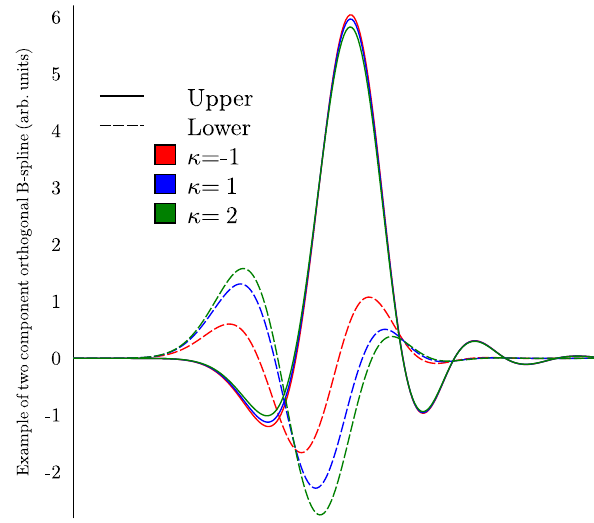
Figure 1. Examples of the same two component orthogonal B-spline for three partial waves with κ = − 1,1,2. The radial variable here and below is proportional to the logarithm of the